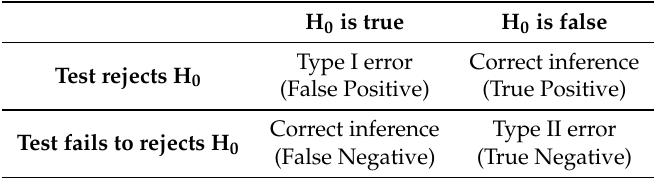
Table 3. Table of truth, also known as the confusion